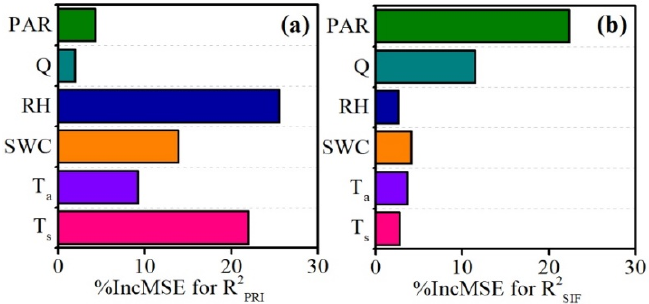
Figure 6. Relative contributions of the environmental variables for explaining ( a ) R 2PRI , the correlation between LUE PRI ×APAR and GPP EC , ( b ) R 2SIF , the correlation between SIF can and GPP EC .